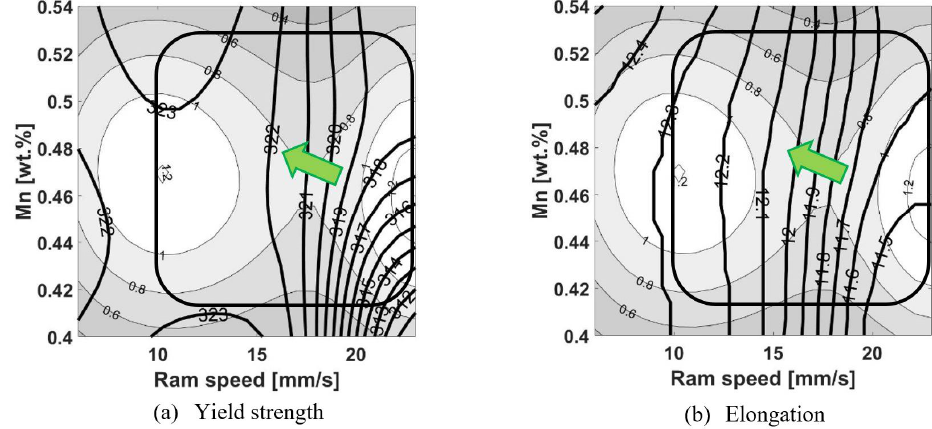
Figure 6. Common influence of ram speed and Mn content on ( a ) yield strength and ( b ) elongation. Green (grey) arrows indicate increase of the observed mechanical property.